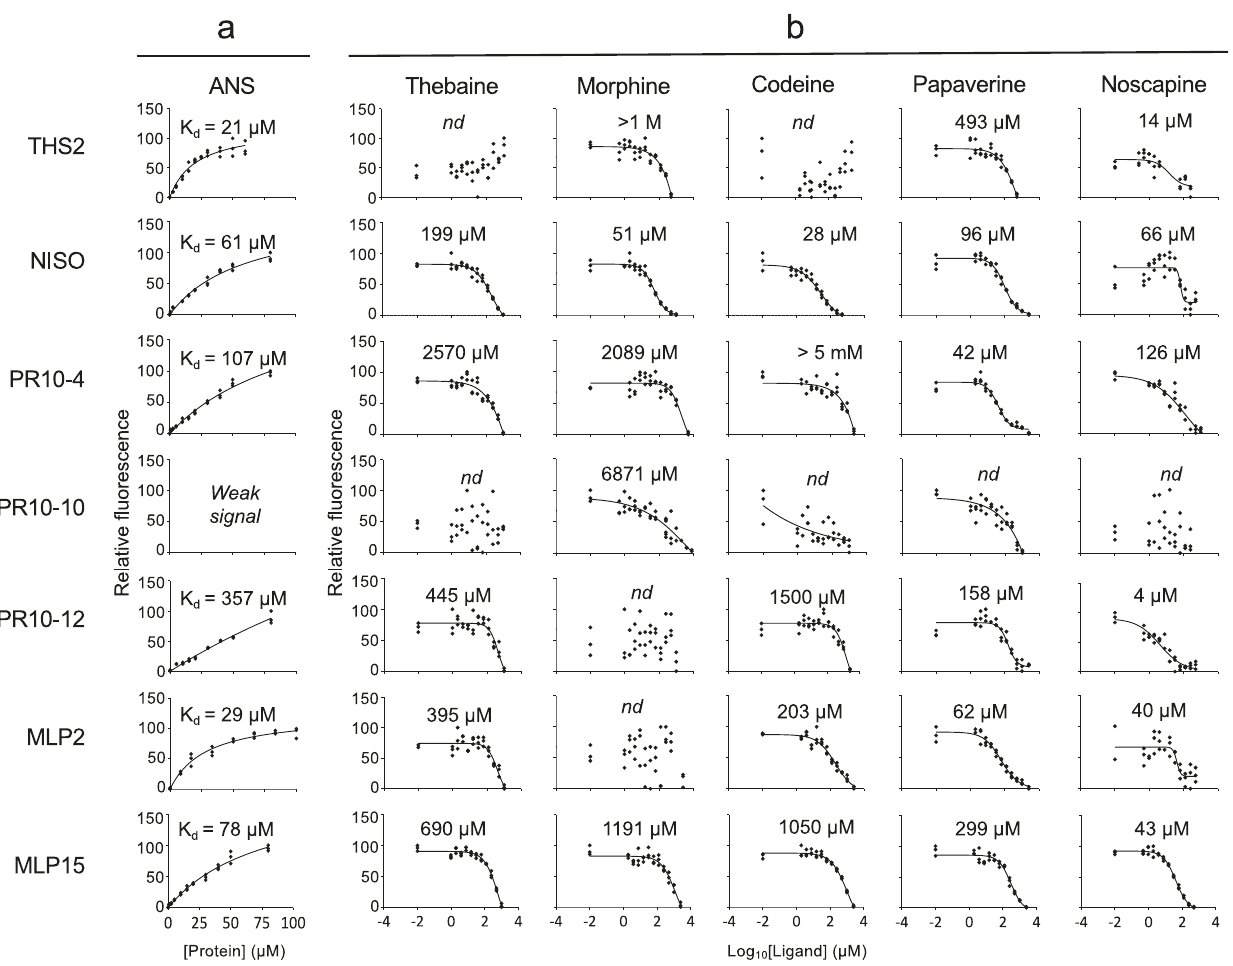
ANS displacement and corresponding IC 50 values. Assuming competitive inhibi- tion, dose-response binding curves were fi t, and apparent K d were calculated from the ANS af fi nity, and IC 50 values were determined (Supplementary Table 3). Data shown is representative of three fully independent experiments. Weak signal indicates insuf fi cient ANS fl uorescence to determine K d . Abbreviation: nd, not